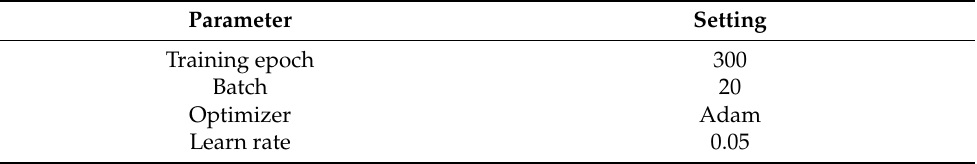
Table 2. Hyper-parameters for the music emotion representation model emoDNN.